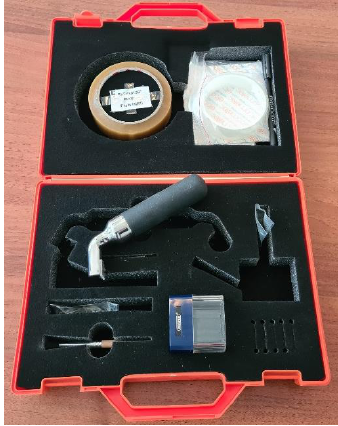
Figure 8. Elcometer 107 Cross-hatch cutter.